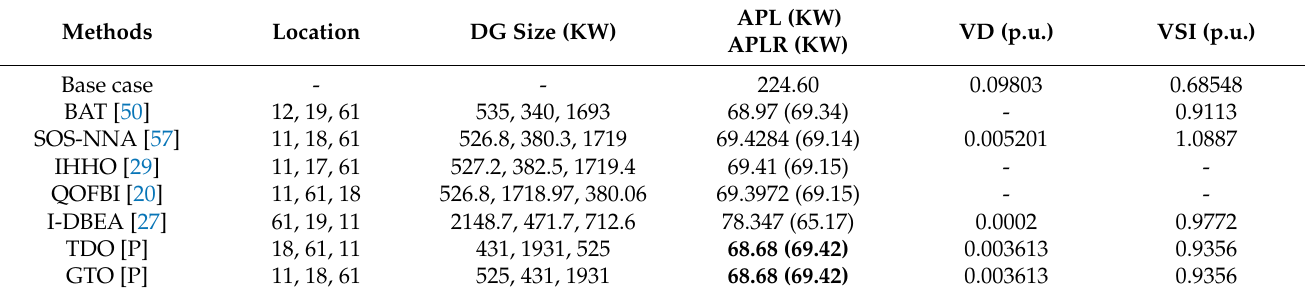
Table 11. Results comparison of OADG for a 69-bus RDN for SOF (APL minimization) at unity pf (PV type) in the CP load